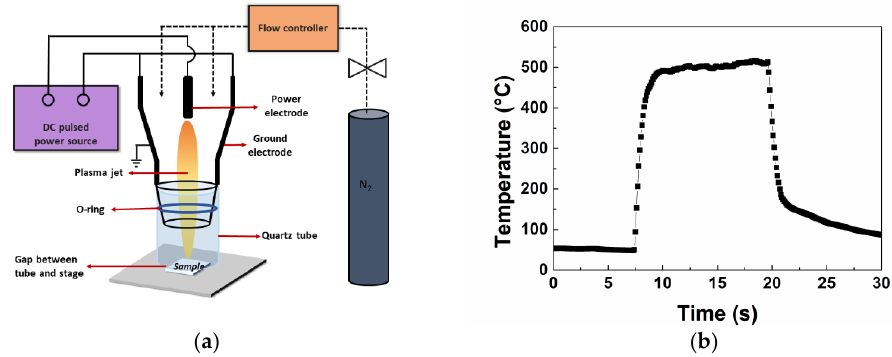
Figure 1. ( a ) Schematic of APPJ setup; ( b ) Temperature evolution of substrate during APPJ treatment.